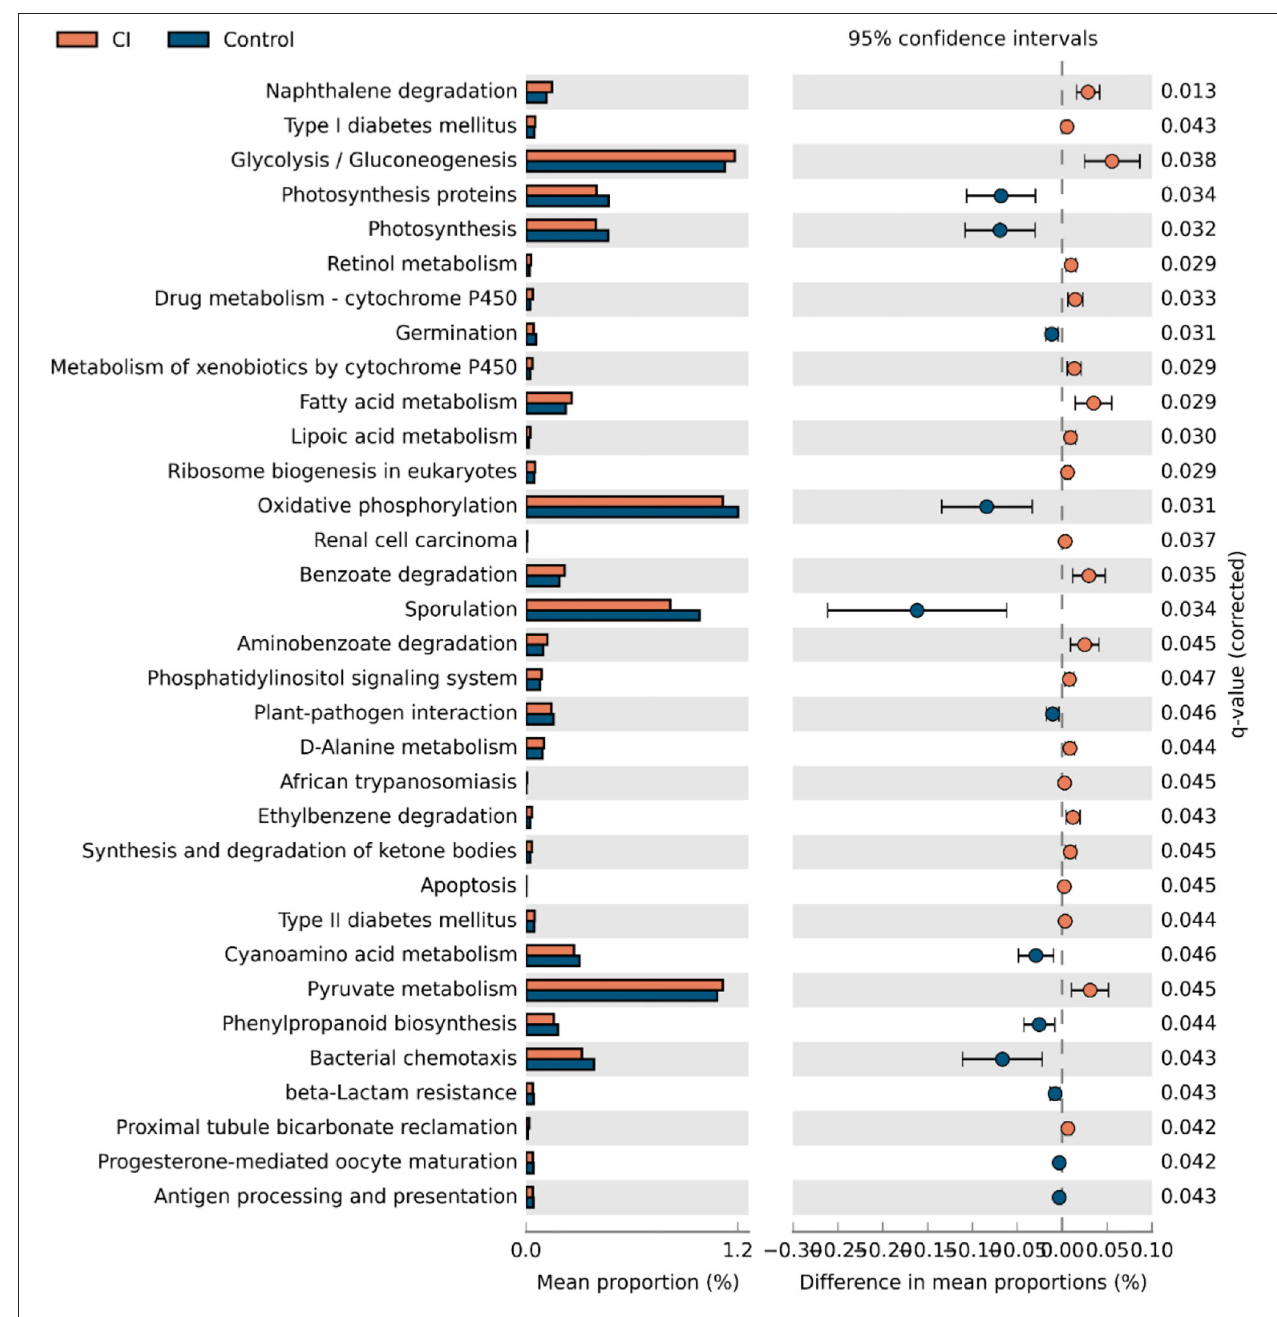
FIGURE 5 | Alterations of gene functions of gut